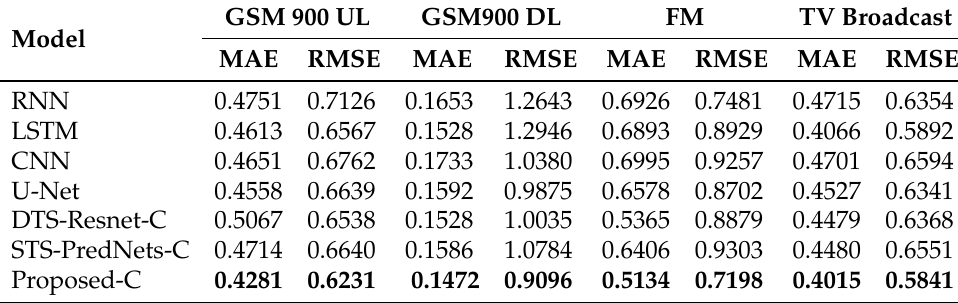
Table 3. Prediction performance on SDR dataset.